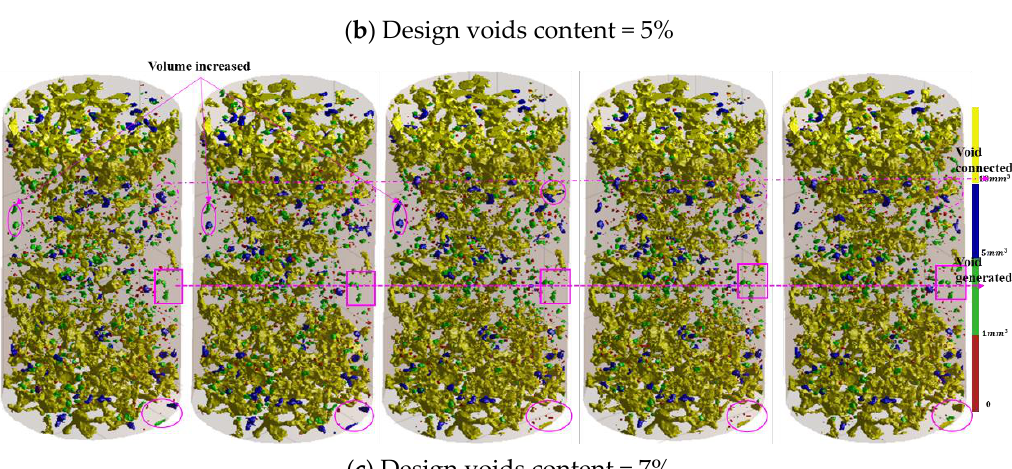
Table 5. Design voids content = 3%.